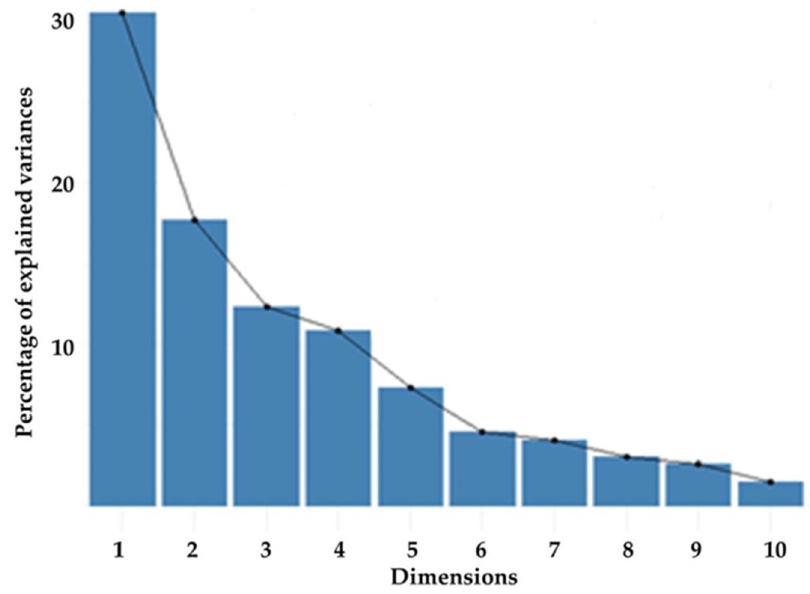
Figure 1. Contribution of components on explained total variance.